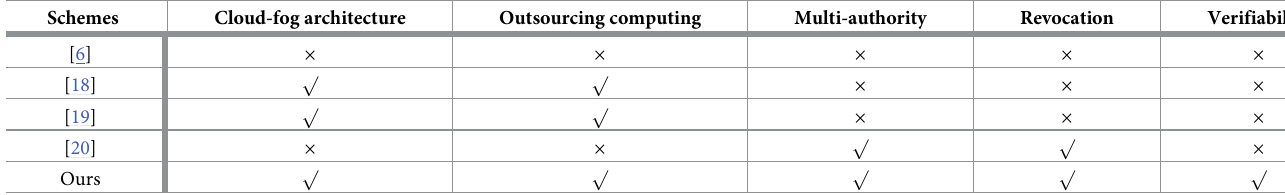
Table 2. The functions comparison.